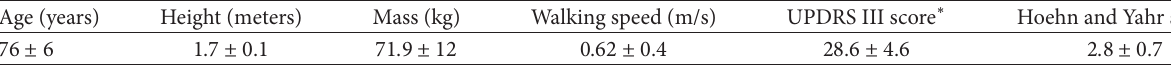
Table 1: Subjects’ initial measurements.